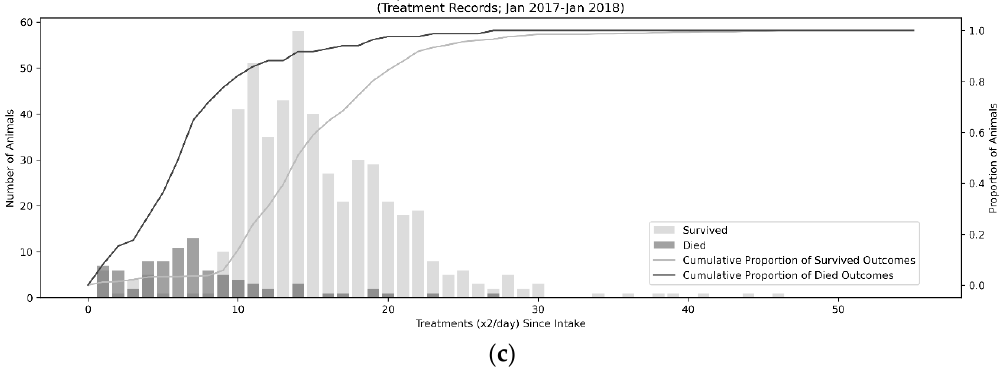
Figure 2. Event plot ( a ) and Kaplan–Meier curve ( b ) for survival over time ( c ) for Canine parvovirus (CPV)-infected dogs. Darker lines in the death/discharge events plot (a) represent animals who did not survive. Distribution of Survived and Died outcomes by treatment shift can be seen in panel (c) with 80% of deaths occurring on or before the 10th treatment, which, at two treatments/day, is on the 5th day.